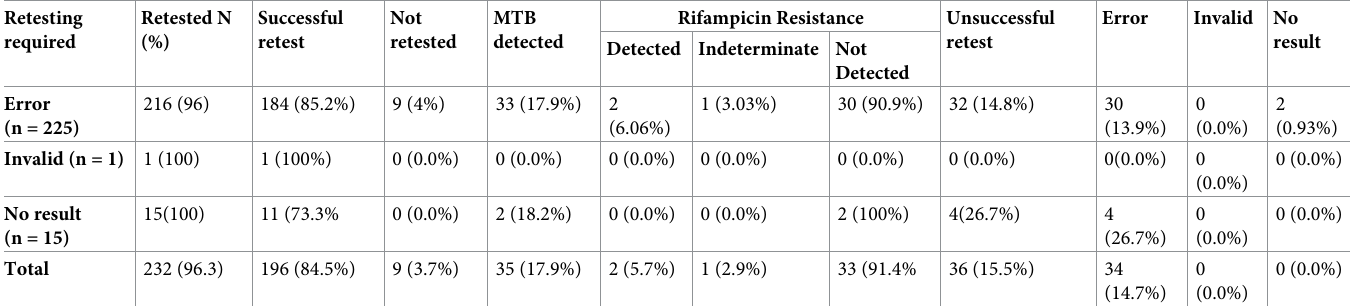
Table 4. Xpert MTB/RIF retest results after initial test yielded unsuccessful test results (error, invalid, and no result), n = 232.